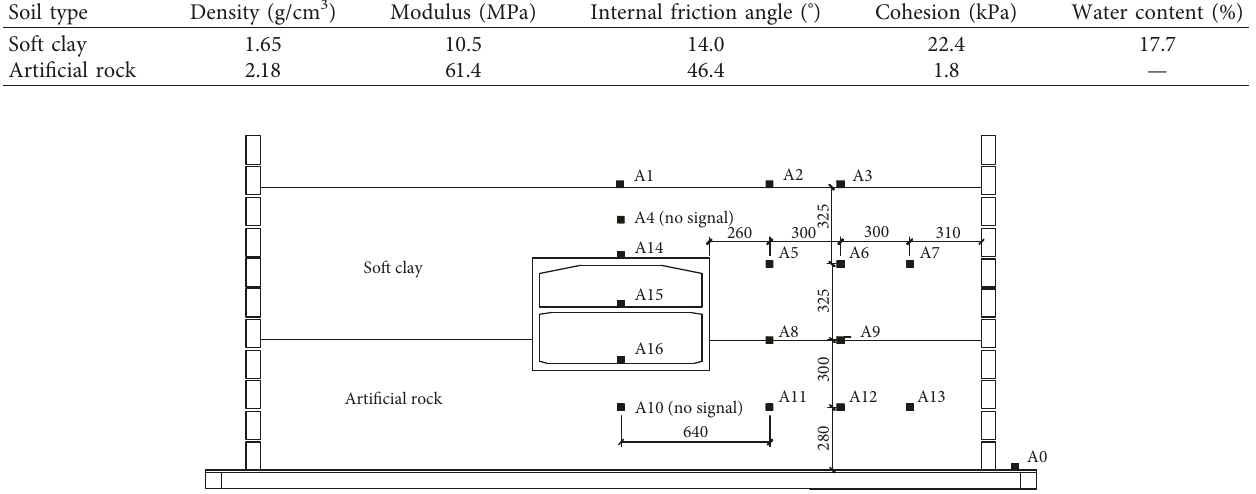
Figure 8: Layout of the accelerometers in the model structure and soil (unit: mm).